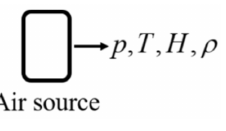
Figure 9. Interface parameters of air